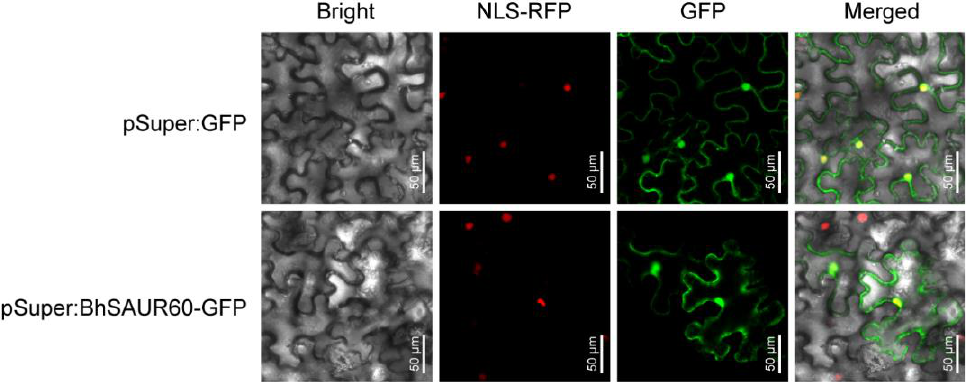
Figure 7. Subcellular localization of the BhSAUR60 Protein.